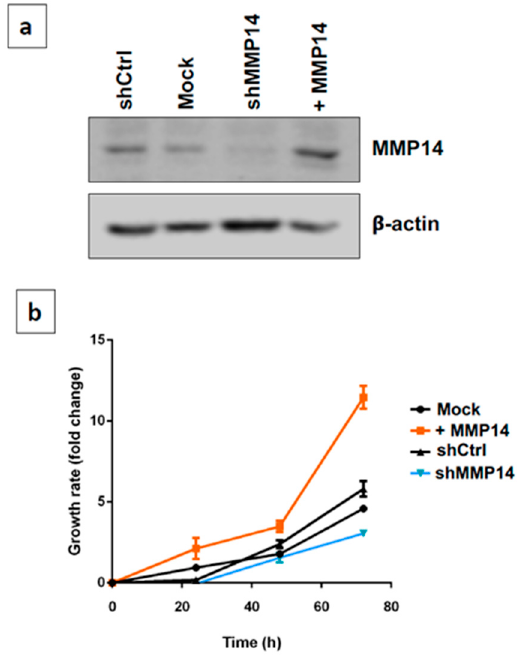
Figure 5. Effect of gain and loss of MMP14 on growth rate in A549 epithelial cells. ( a ) Western blot showing the attenuation of MMP14 in silenced cells and its overexpression in MMP14 transfected cells. ( b ) Cell overexpressing MMP14 showed increased growth rate, while the silencing decreases growth rate (mean ± standard deviation (SD)). Graphics represent one of three independent experiments by triplicate.